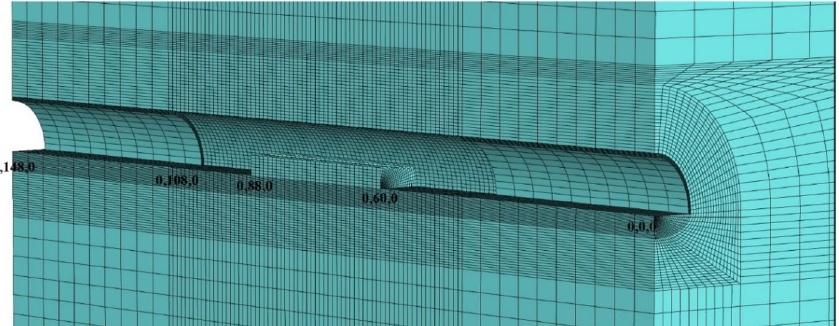
Figure 25. Tunnel excavation situation after stage 53.